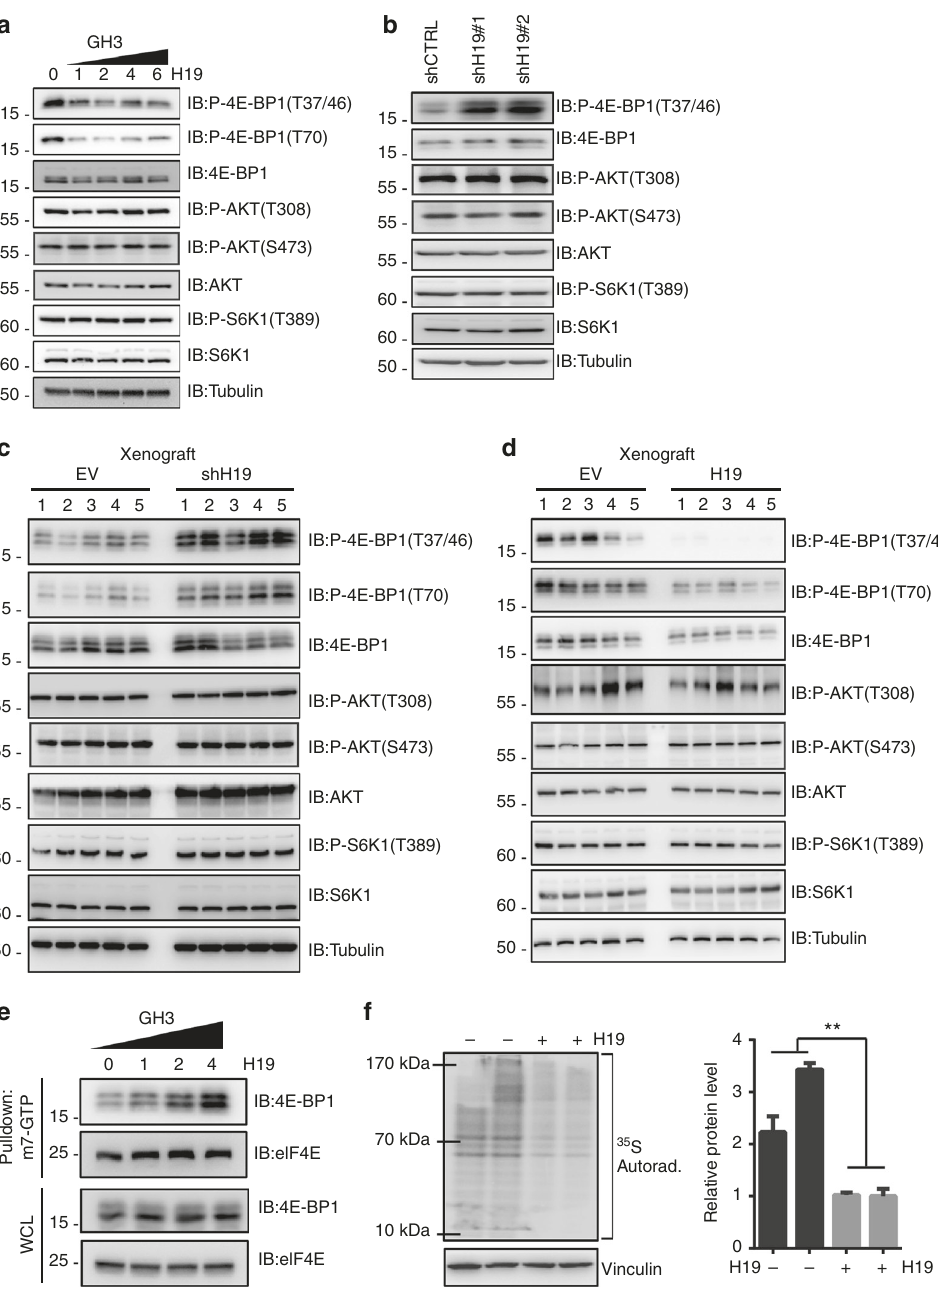
Fig. 3 H19 decreases the phosphorylation level of 4E-BP1. a H19 overexpression suppresses 4E-BP1 phosphorylation in GH3 cells. At 48 h post-transfection, with an increasing dose of H19 in GH3 cells, the resulting cells were collected, and the protein levels of phosphorylated 4E-BP1 Thr70, phosphorylated 4E- BP1 Thr37/46, total 4E-BP1, total AKT, phosphorylated AKT Thr308, total S6K1 and phosphorylated S6K1 were examined by western blot. Tubulin was used as the loading control. b H19 knockdown increases the 4E-BP1 phosphorylation in GH3 cells. GH3 cells were infected with lentiviral H19 shRNA1 and shRNA-2 or a control shRNA. The protein levels of phosphorylated 4E-BP1 Thr37/46, total 4E-BP1, total AKT, phosphorylated AKT Thr308, total S6K1 and phosphorylated S6K1 were examined by western blot. c Overexpression of H19 suppresses 4E-BP1 phosphorylation in GH3 xenograft tumours. Some of the tumour tissues from Fig. 2g were homogenized in lysis buffer with a tissue homogenizer; then, the samples were centrifuged, and the supernatant was collected and used for immunoblotting analysis with the indicated antibodies. d Knockdown of H19 in GH3 xenograft tumours enhances 4E-BP1 phosphorylation. Some of the tumour tissues from Fig. 2j were homogenized in lysis buffer with a tissue homogenizer; then, the samples were centrifuged, and the supernatant was collected and used for immunoblotting analysis with the indicated antibodies. e H19 overexpression increases the amount of eIF4E complex bound to the cap analogue m7GTP Sepharose. Whole-cell lysates derived from GH3 cells that were transfected with the indicated dose of H19 were precipitated with m7GTP Sepharose beads followed by immunoblot analysis with the indicated antibodies. f H19 inhibits the total translation level in GH3 cells. 35 S labelling of newly synthesized protein was detected by autoradiography (left panel). Quanti fi cation of the results using ImageJ (right panel). The experiments were repeated three times. The data shown re fl ect relative protein synthesis normalized to the control without H19 overexpression. ** p < 0.01, two-tailed Student ’ s t -test was used for statistical